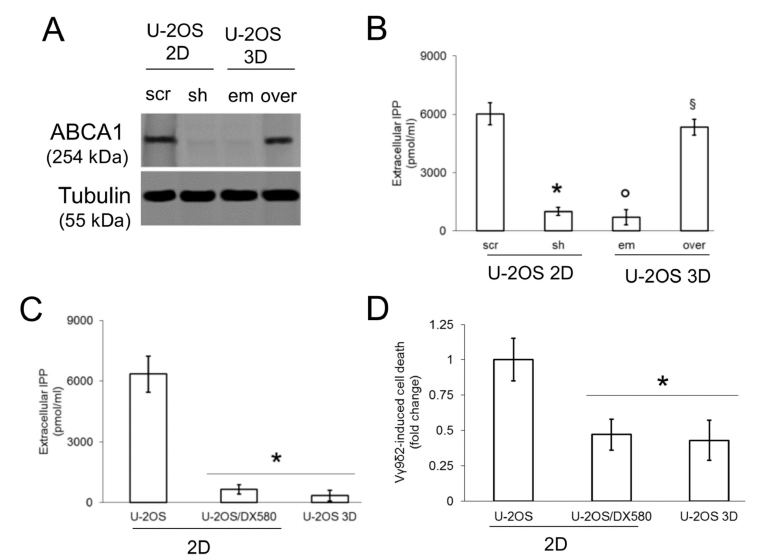
Figure 2. ABCA1 e ffl uxes isopentenyl pyrophosphate (IPP) and mediates the activation of V γ 9 δ